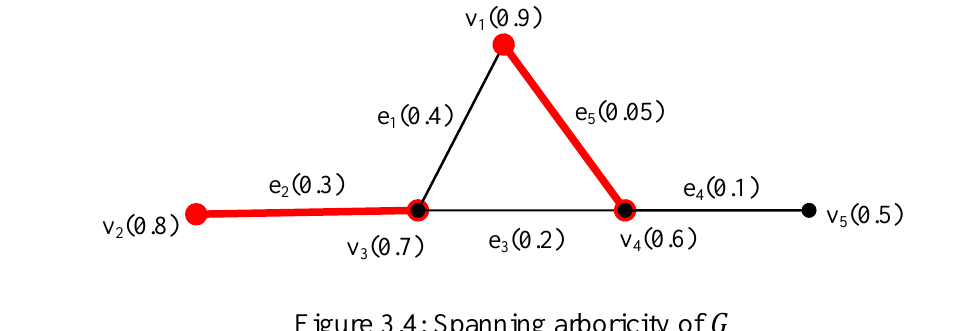
Figure 3.4: Spanning arboricity of